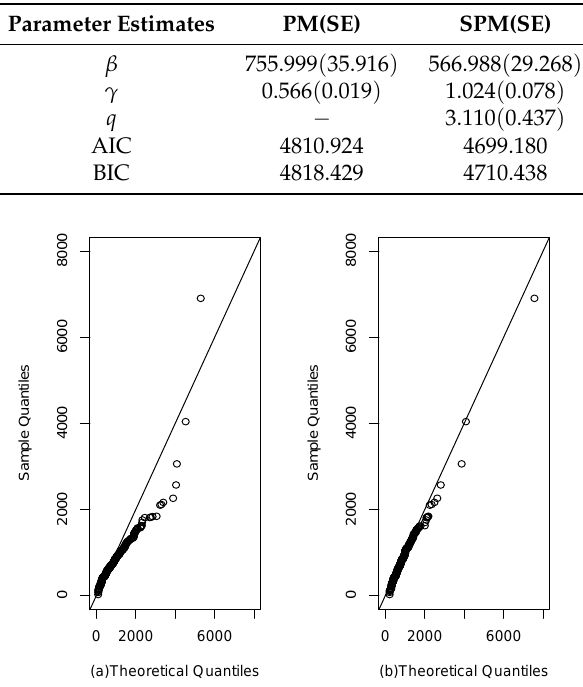
Figure 6. qqplots for retinol dataset: ( a ) PM model; ( b ) SPM